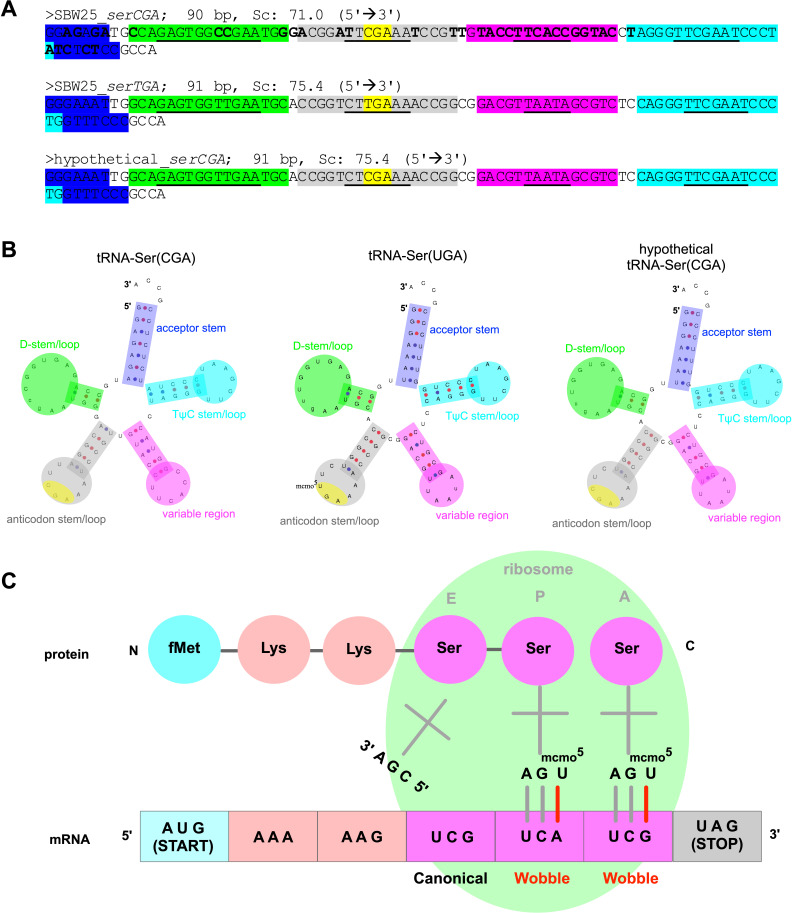
Predicted structure and function of tRNA types tRNA-Ser(CGA) and tRNA-Ser(UGA) in P. fluorescens SBW25.(A) Gene sequences for P. fluorescens SBW25 serCGA (top), P. fluorescens SBW25 serTGA (middle), and hypothetical serCGA (serTGA backbone with a single point mutation to a CGA anticodon; see Discussion). Colour highlights indicate various parts of each tRNA, with the base pairing (stem) components in each region underlined (blue = acceptor stem, green = D stem/loop, grey = anticodon stem/loop, yellow = anticodon, pink = variable region, turquoise = TψC stem/loop). Bold letters in serCGA indicate 36 nucleotide differences from serTGA. (B) Predicted mature tRNA structures for the tRNA sequences in panel A, using tRNAscan-SE v2.0 (Chan and Lowe, 2019). The predicted CmoA/B/M mediated post-transcriptional modification U34→cmo5U34 is also shown in tRNA-Ser(UGA). (C) Cartoon depicting translation of serine codons: canonical base pairing occurred between tRNA-Ser(CGA) and UCG, and wobble base pairing is occurring between post-transcriptionally modified tRNA-Ser(UGA) and codons UCA and UCG.